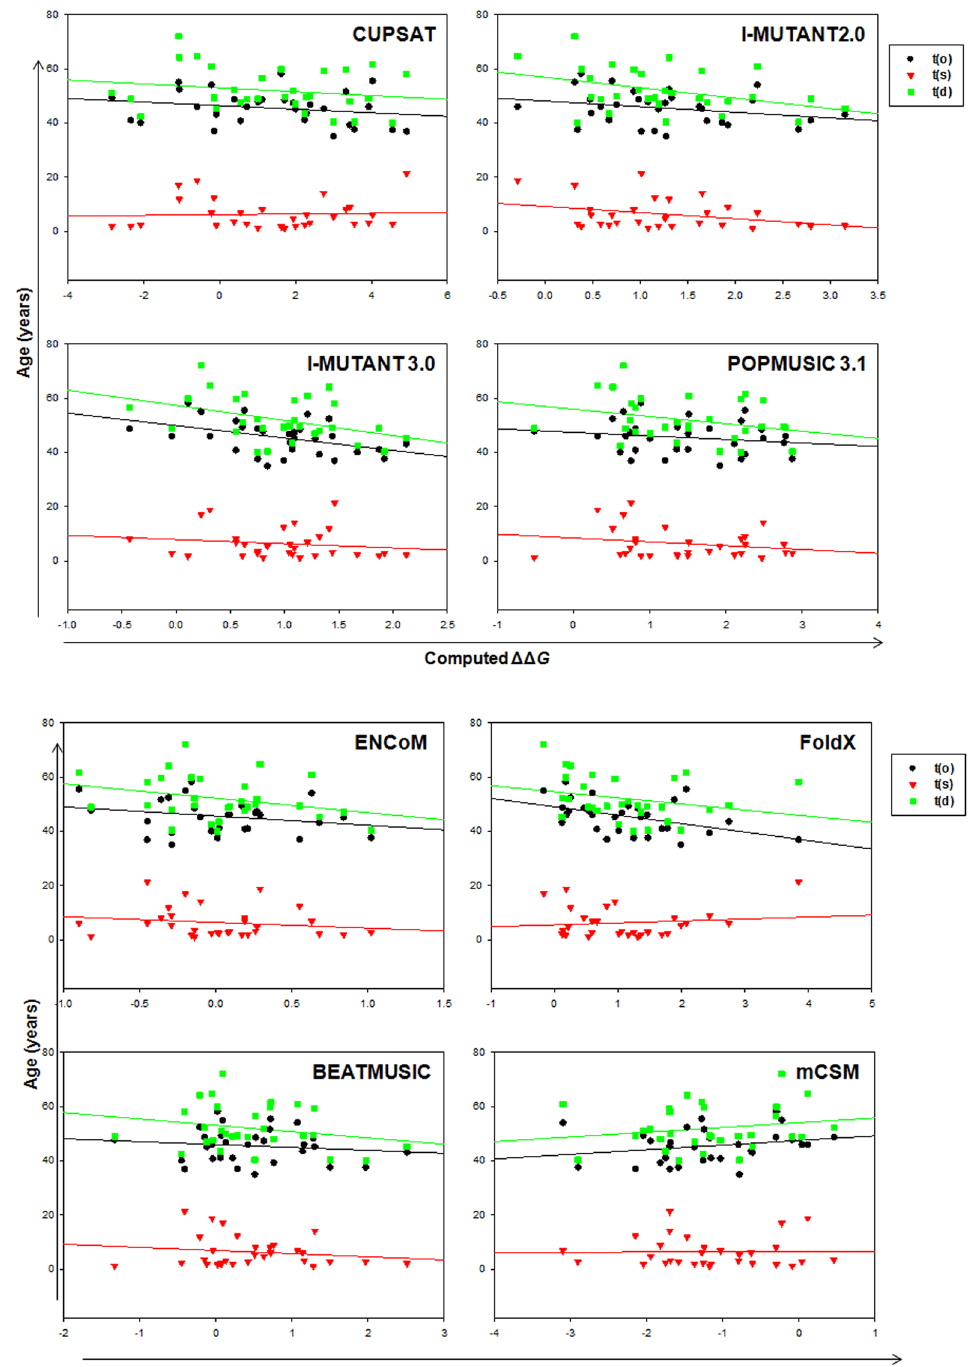
Figure 6. Correlation between predicted stability changes for 30 mutations in ALS with patients data, t(o), t(s) and t(d), using real holodimer of SOD1 structure,